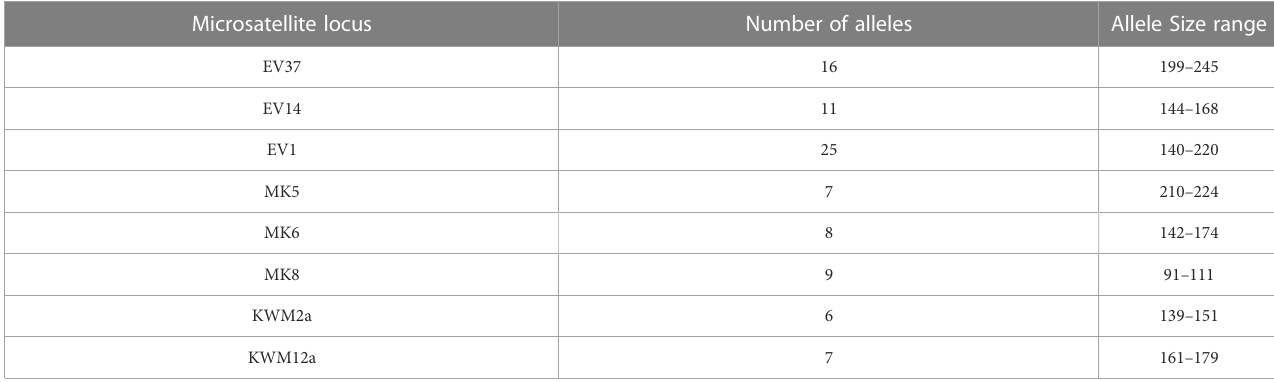
TABLE 1 Size range and number of alleles of the various microsatellite loci in the Sarasota Bay Dolphin Community.